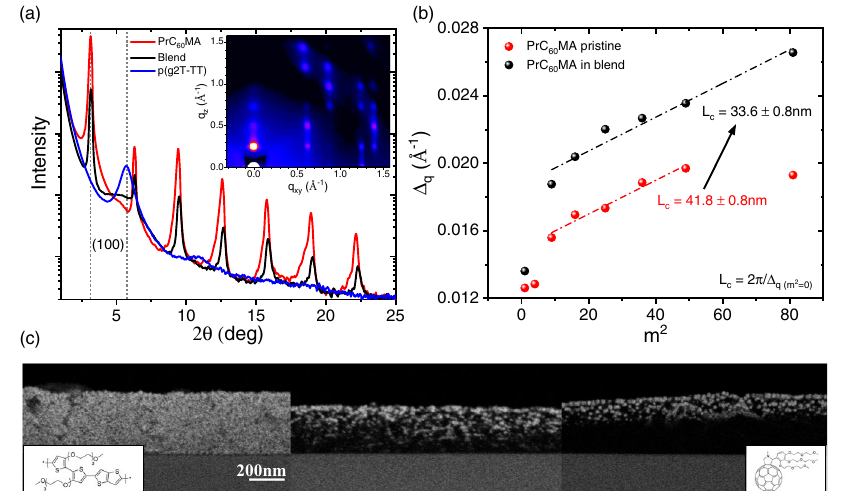
Fig. 3 | Structural characterization. a Out-of-plane XRD of pristine materials and order provides theL c 55,63 (Supplementary Fig. 10). c Back-Scattered Electrons (BSE) the95:5w:wPrC 60 MA:p(g2T-TT)blendandtheGrazingIncidenceWide-AngleX-ray detector cross-section High Resolution Scanning Electron Microscopy (HRSEM) Scattering(GIWAXS)measurementoftheblend(inset).Dottedlinesat2 θ =3.1°and images of the p(g2T-TT) (left), 95:5 blend (middle), and PrC 60 MA (right) fi lms fol- lowing aVapor Phase In fi ltration (VPI) ‘ staining ’ process. The bright contrast is due 5.7°areassociatedwiththe(100)peaksofPrC 60 MAandp(g2T-TT),respectively.All other peaks are higher (h00) re fl ections of PrC 60 MA. b Scherrer analysis of the to nucleation and growth of ZnO particles. The distribution of ZnO particles coherence length (L c ) of PrC 60 MA crystals in pristine and 95:5 blend fi lms using a throughout the blend fi lm, in contrast to the pristine PrC 60 MA fi lm, corroborates pseudo-voigt function fi tting. In this analysis the FWHM of each (h00) re fl ection, the bulk-heterojunction morphology. The scale bar is fl ection order, m 2 , and the extrapolation to the 0 th 4 q , is plotted vs the square re